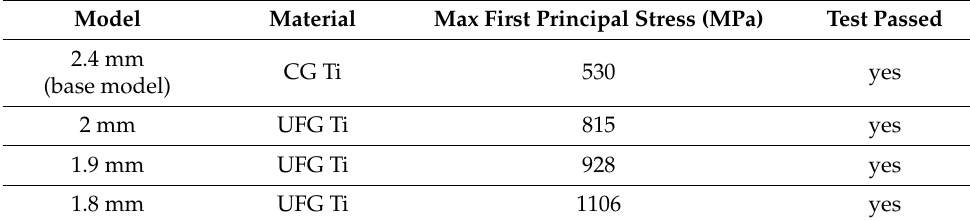
Table 3. Results of virtual static strength